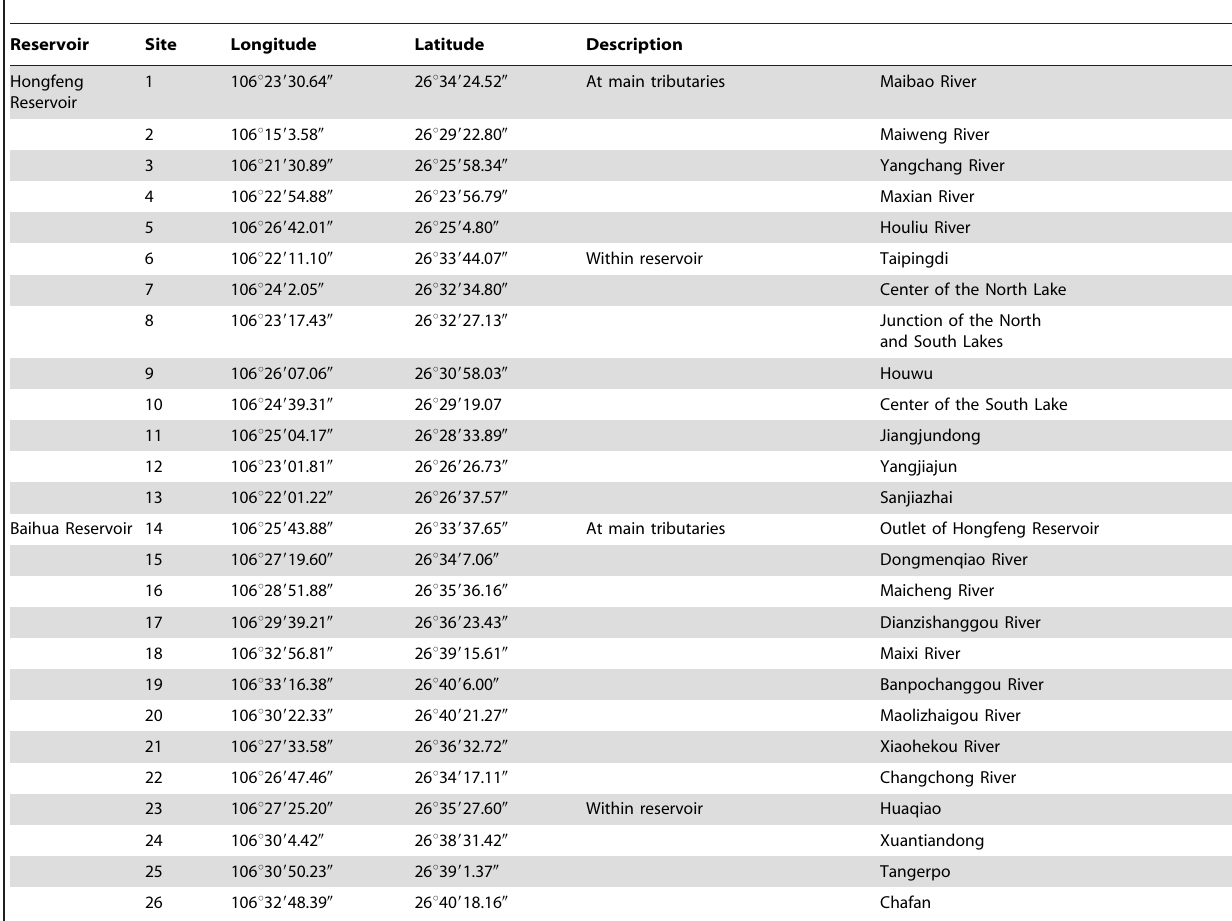
Table 1. Locations of sampling sites in the Hongfeng and Baihua Reservoirs on the Yunnan-Guizhou Plateau, Southwest China.